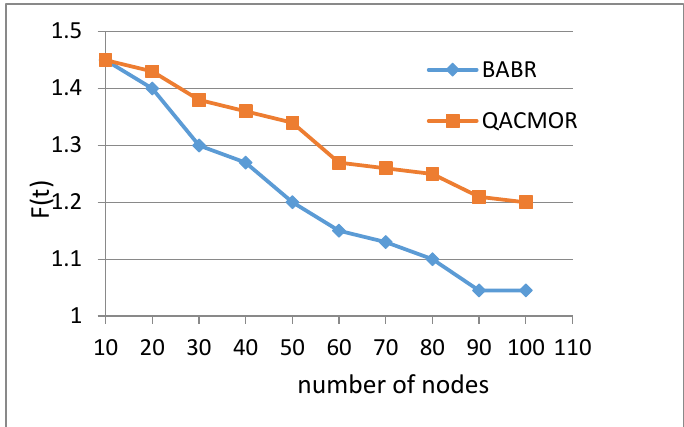
Figure 6. Value of optimal route vs. number of nodes.